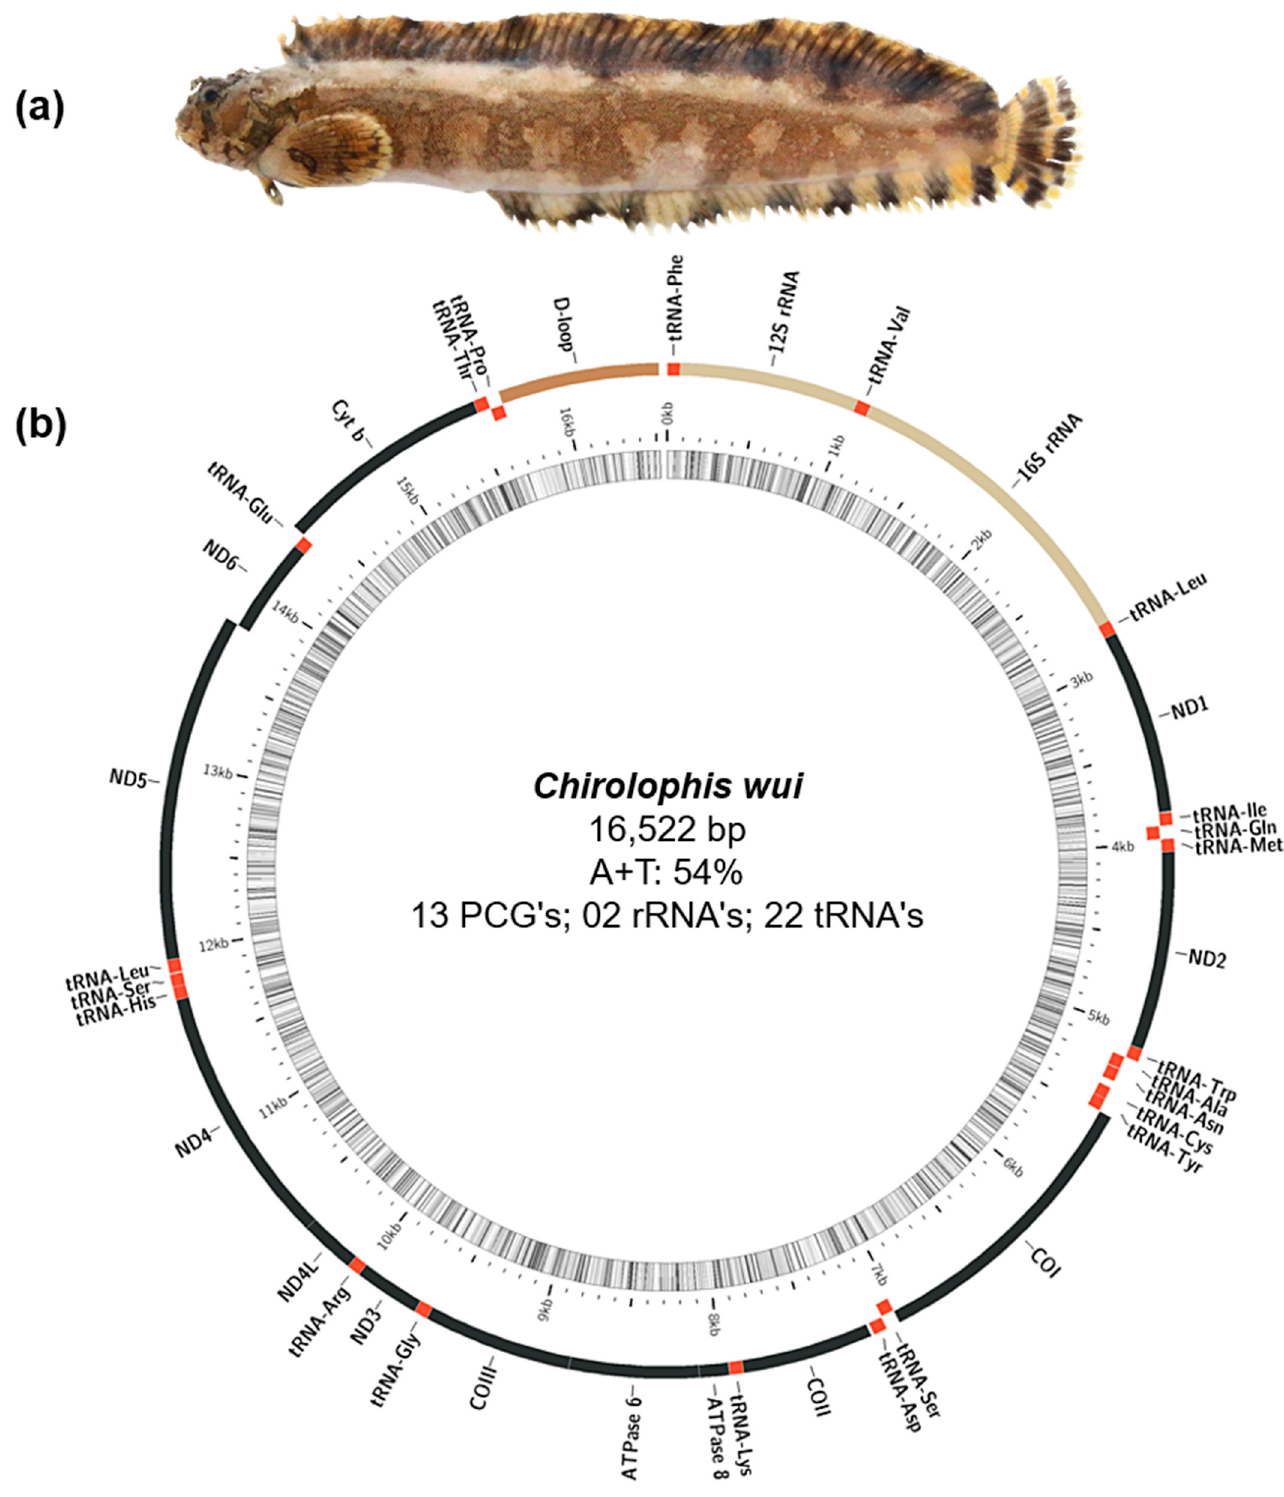
Figure 2. Sample image and the mitochondrial genome map of Chirolophis wui . ( a ) Specimen reference image; ( b ) the mitochondrial genome of C. wui . Genes outside the circle are transcribed in a clockwise direction and those inside in a counterclockwise direction.